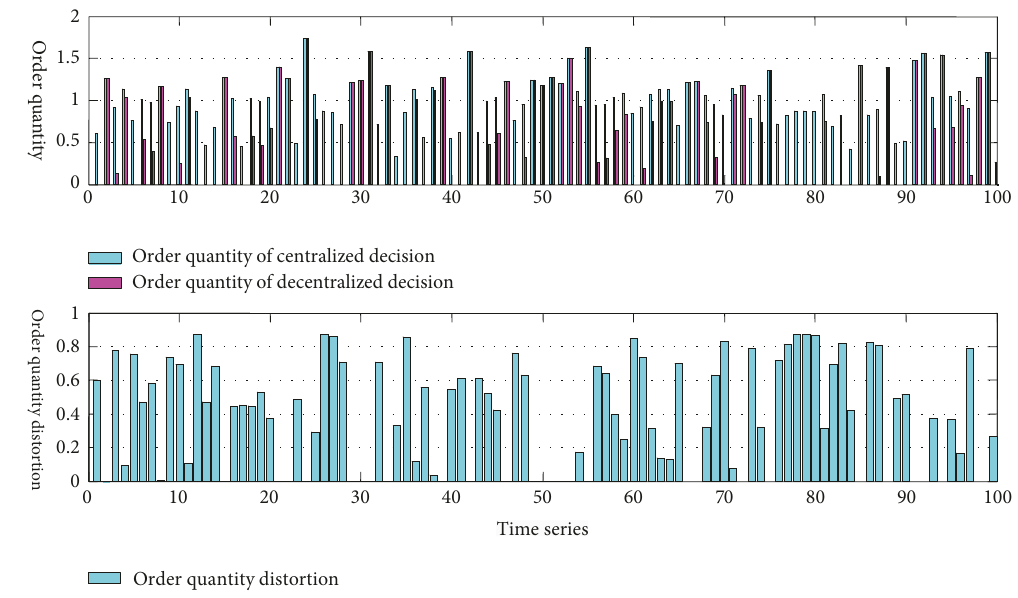
Figure 5: Order quantity and order quantity distortion.